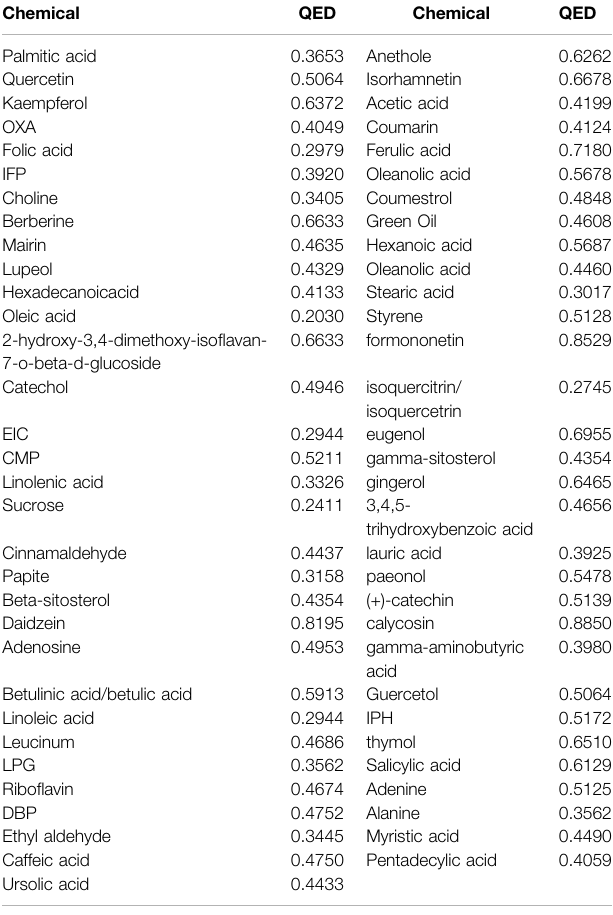
TABLE 2 | Bioactive compounds of Huangqi Jianzhong Tang. Chemical QED Chemical QED Palmitic acid